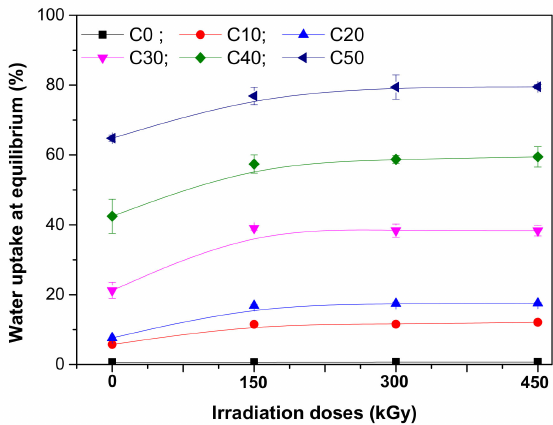
Figure 7. Water uptake at equilibrium of NR/PS